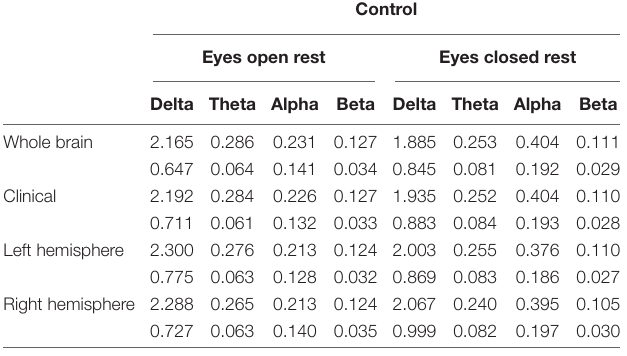
Supplementary Table 2 for skew and kurtosis values for all measures). Therefore, Mann–Whitney U tests were conducted for alpha power comparisons.